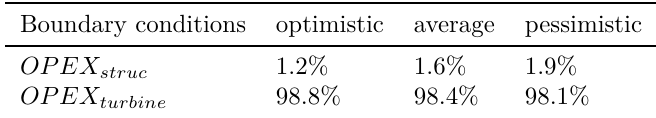
Table 4. Relative contribution of OPEX